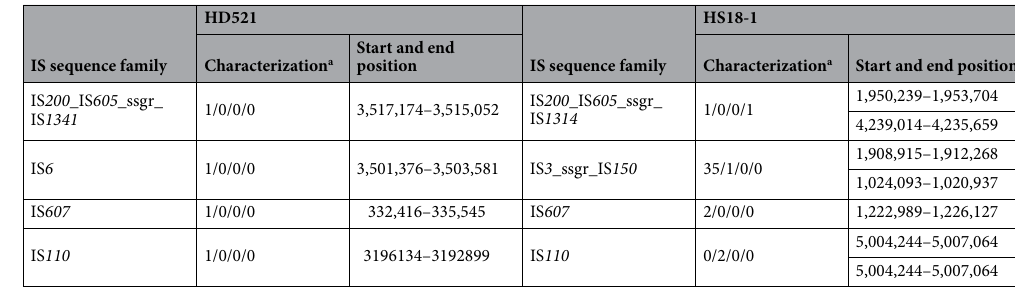
Table 3. The varieties and quantities of IS in HD521 and HS18-1 genome. a Complete sequence/partial sequence/pseudogenes/unknown